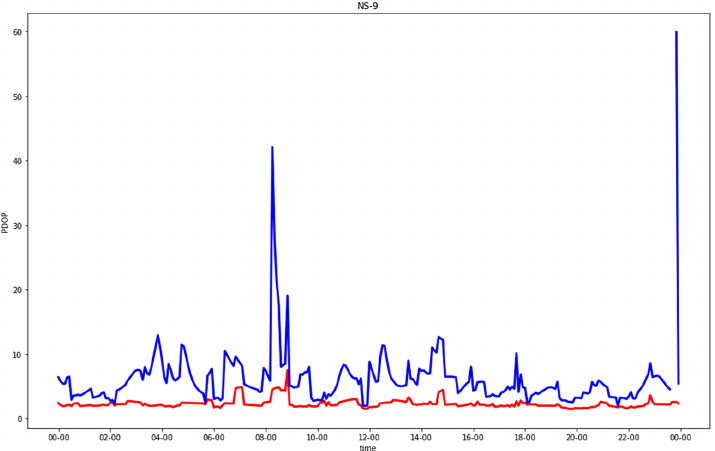
Figure 6. PDOP in north-south residential street for GNSS-alone (blue) compared with GNSS + five 5G stations (red), plotting only results with PDOP <